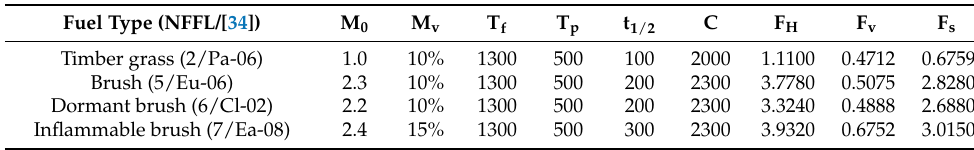
Table 4. Fuel-type-dependent input variable values.